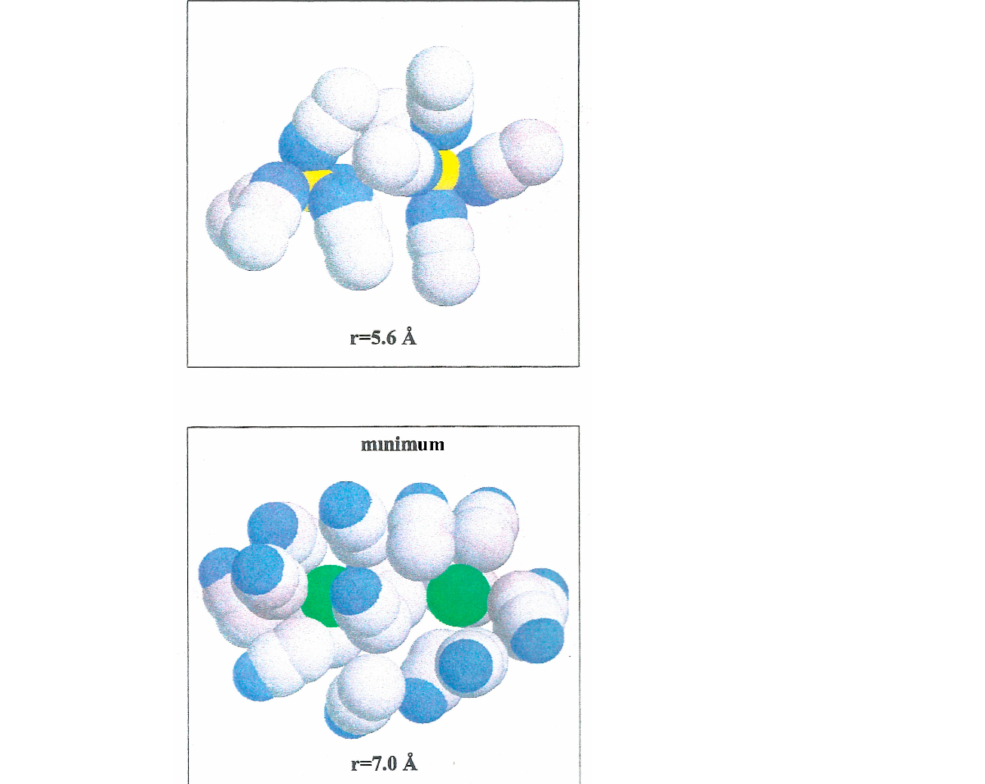
Figure 7. Configurations of acetonitrile clusters illustrating the arrangements of solvent molecules around Li + -Li + , and Br − -Br − ion pairs at two interionic separations. Li + (yellow color) , Br − (green color) , N (blue color) and C and Me (gray